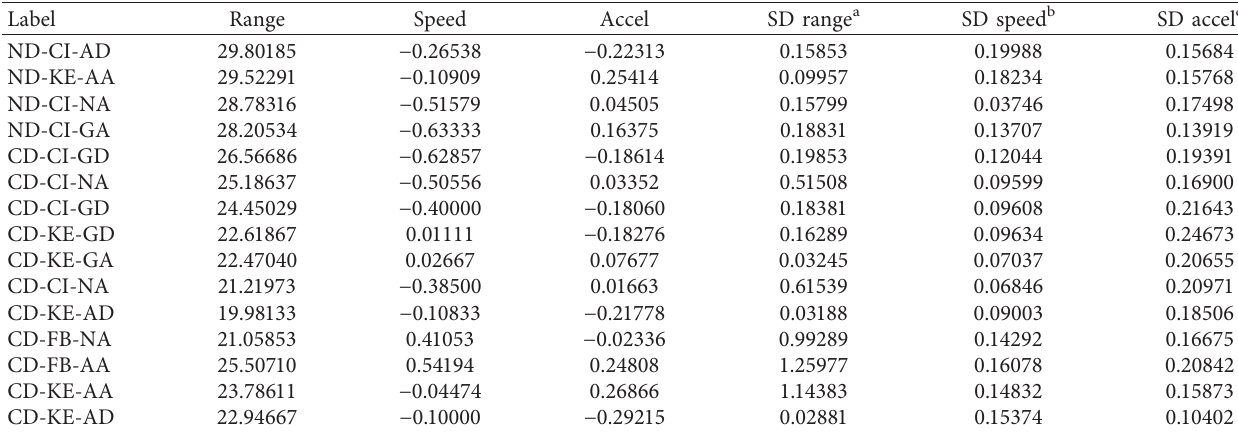
Figure 2: Example of segmentation results of one event for driver #1 using two different models: from top to bottom are HMM (a), MHMM (b). Table 2: K -means centers of driver #1.